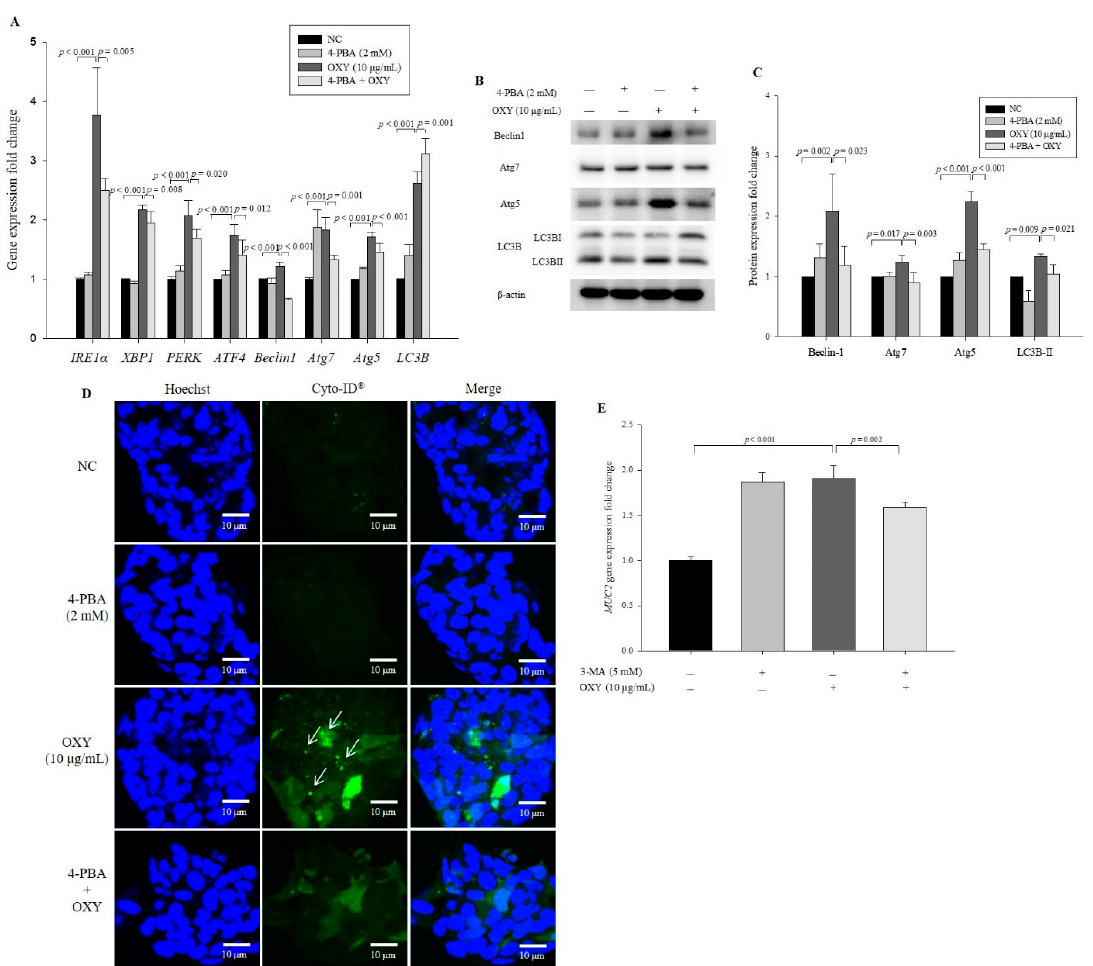
Figure 8. Effect of an ER stress inhibitor on expression of autophagy-related genes and proteins. Cells were treated with OXY (10 µg/mL) with or without the ER stress inhibitor 4-PBA. Expression levels of IRE1 α , XBP1 , PERK , ATF4 , Beclin-1 , Atg5 , Atg7 , and LC3B were determined by qPCR ( A ). Expression levels of Beclin-1, Atg7, Atg5, and LC3B proteins were measured by Western blotting ( B ) and quantified ( C ). From each lysate, equal amounts of protein were loaded on a separate gel, blotted for actin and this signal was used for determining the ratio of the protein of interest / actin as displayed in the figure. The cropped blots are representative of three independent experiments. The full-length blots are shown in Supplementary Figure S6. Autophagic vesicle formation was detected using the CYTO-ID autophagy green dye and observed by fluorescence microscopy; white arrows indicate autophagosomes (magnification 600 × ) ( D ), which were quantified ( E ). Each value indicates the mean ± SD of three independent experiments performed in